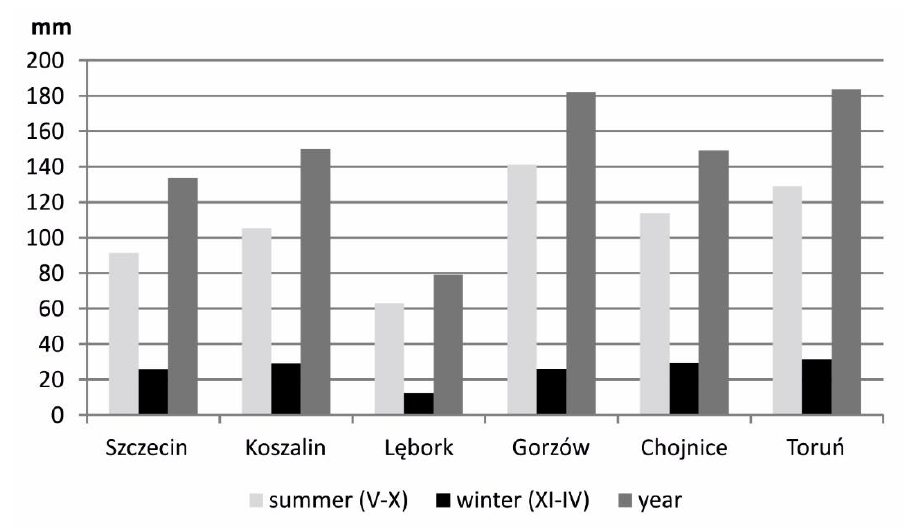
Figure 5. Changes in annual and semi-annual evaporation sums ( E 0 ) calculated from linear regression equations in the studied stations for the years 1952–2018 (calculated based on t and f and data obtained from the Polish Institute of Meteorology and Water Management—National Research Institute [43]).